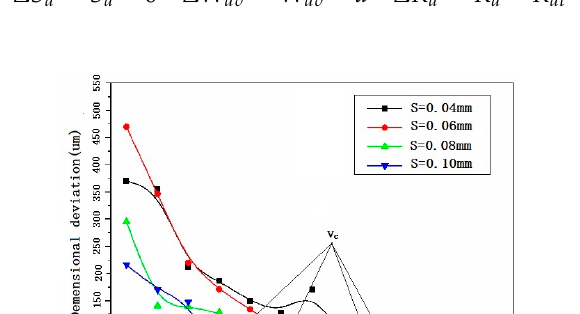
Figure 16. The dimensional deviation of SLMed struts vs. process parameters.